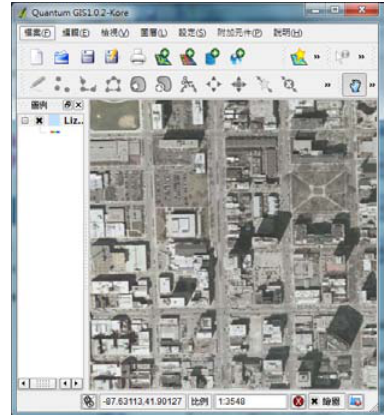
Figure 2 Example of digitizing based WMS